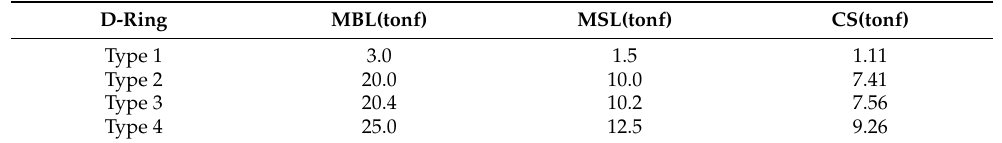
Table 2. CS for 4 types of